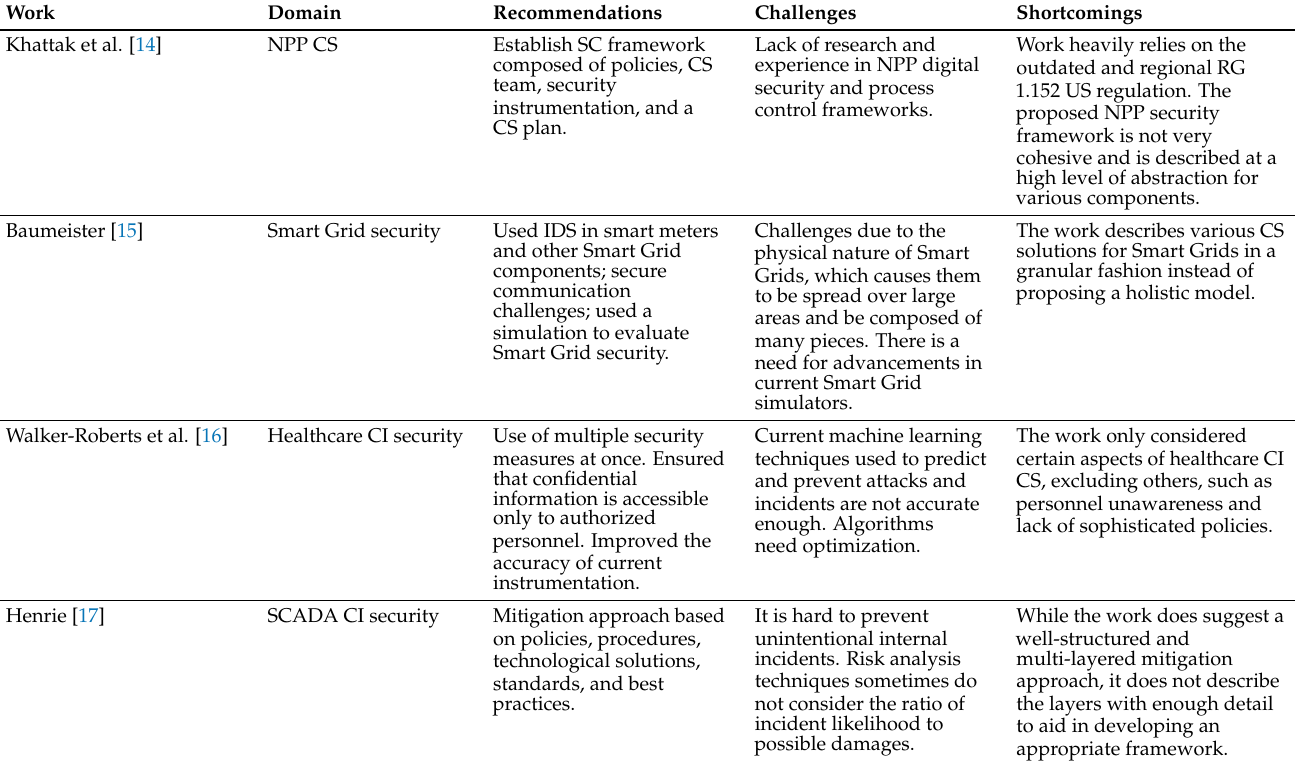
Table 3. Recommendations, challenges, and shortcomings of related survey